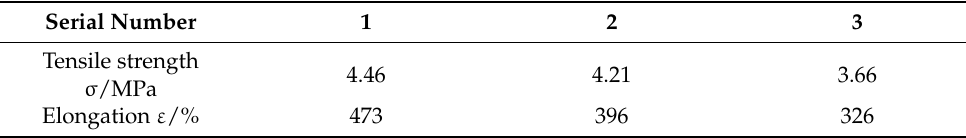
Table 1. Tensile test results of shear thixotropic polymer gel.